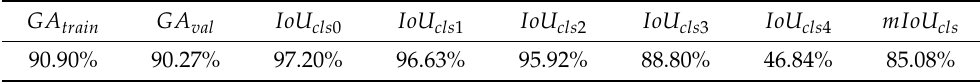
Table 1. The metrics results of our method.